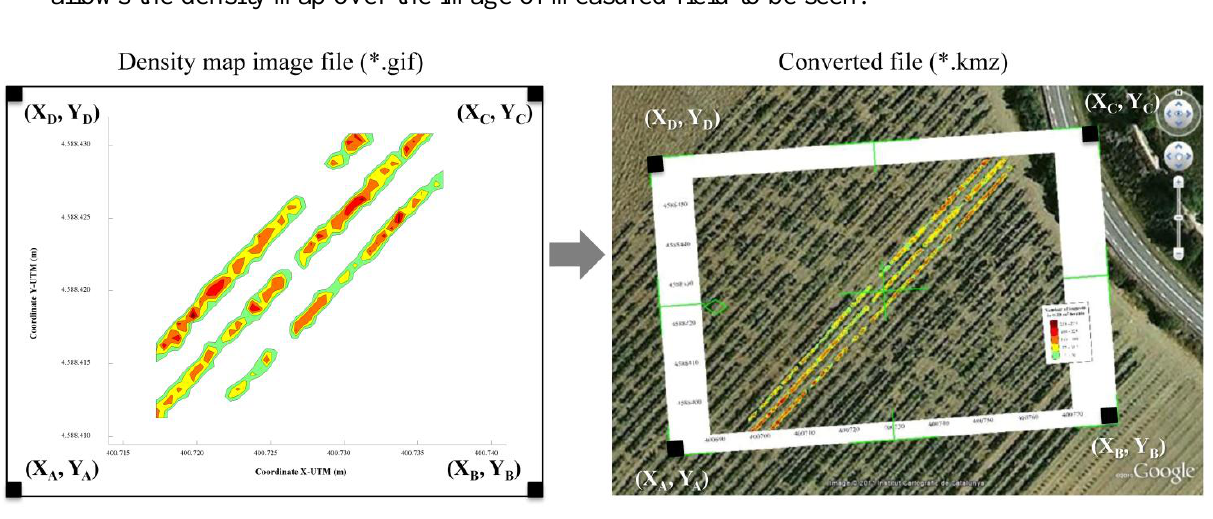
Figure 11. Procedure for the conversion of GIF files to KMZ files. This proposed method allows the density map over the image of measured field to be seen.